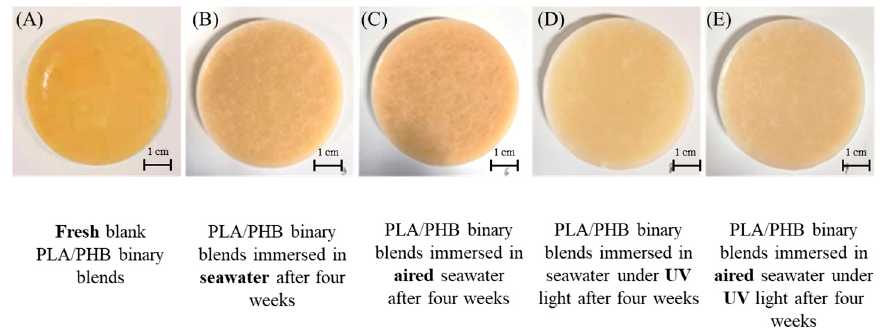
Figure 9. Evolution of the appearance of bulky PLA/PHB plastics before ( A ) and after immersion in seawater under multiple environmental parameters, including ( B ) static seawater, ( C ) aerated seawater, ( D ) UV-lighting static seawater, and ( E ) UV-lighting aerated seawater, for four